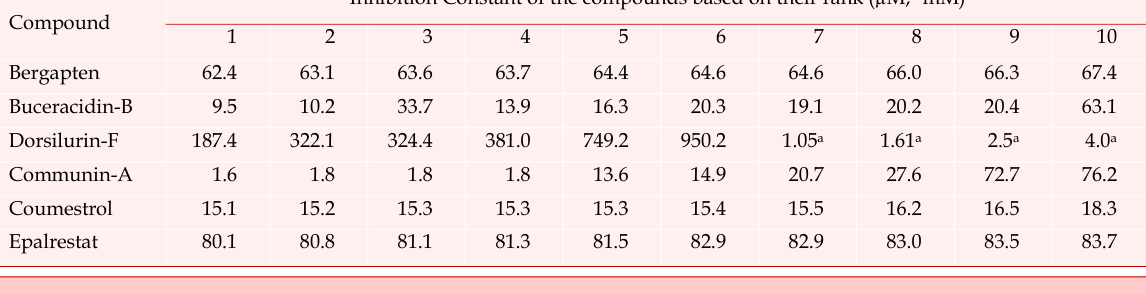
Inhibition constant of the compounds based on their rank Inhibition Constant of the compounds based on their rank (µM, a mM) Compound